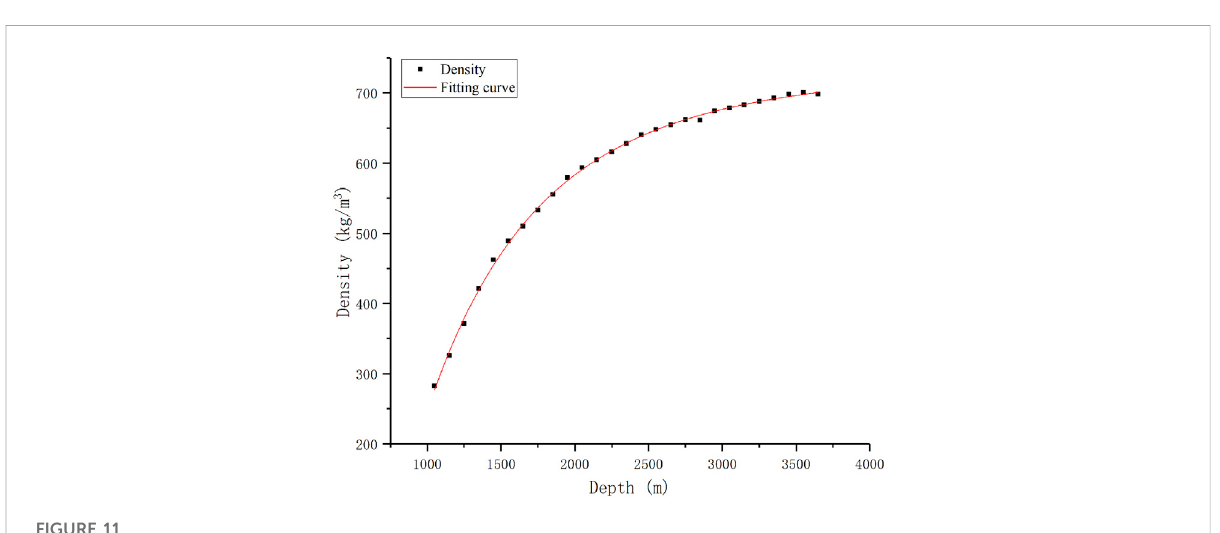
FIGURE 11 The fi tted curve plot of CO 2